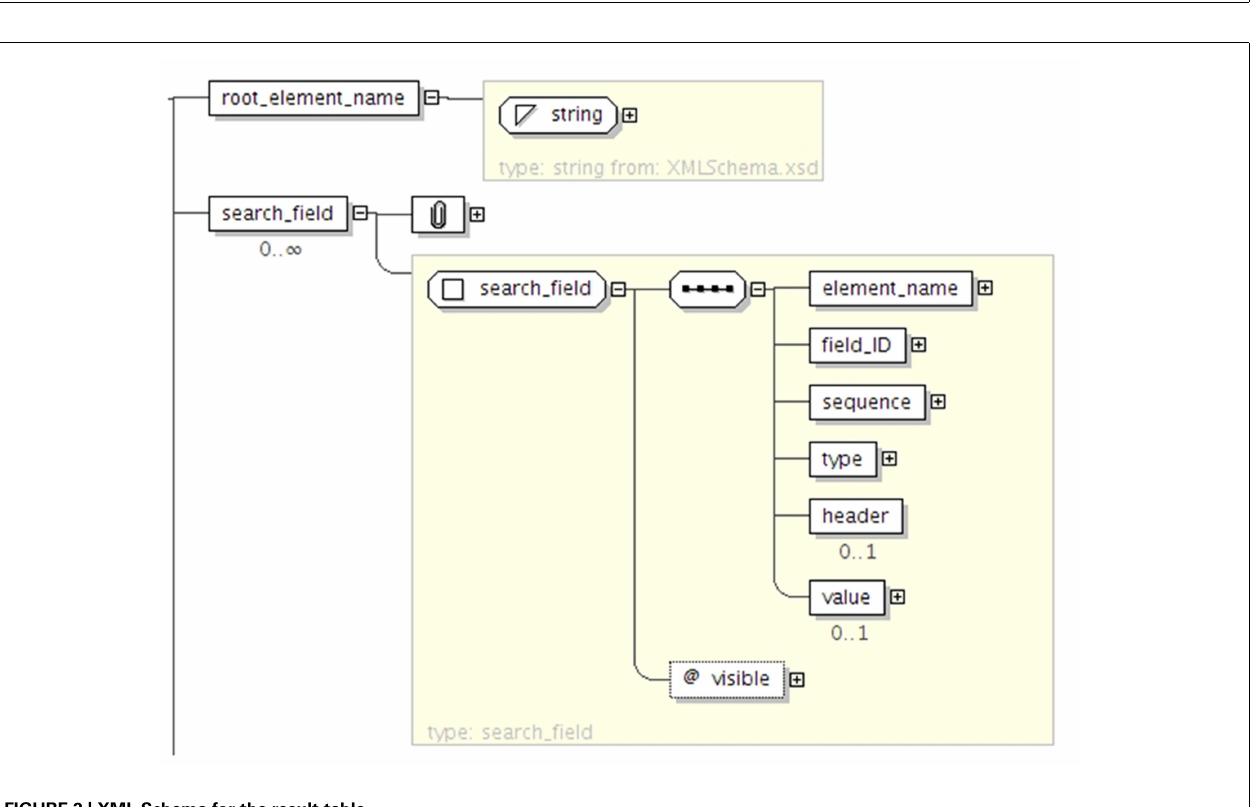
FIGURE 1 | PyXNAT avoids organization on file system.